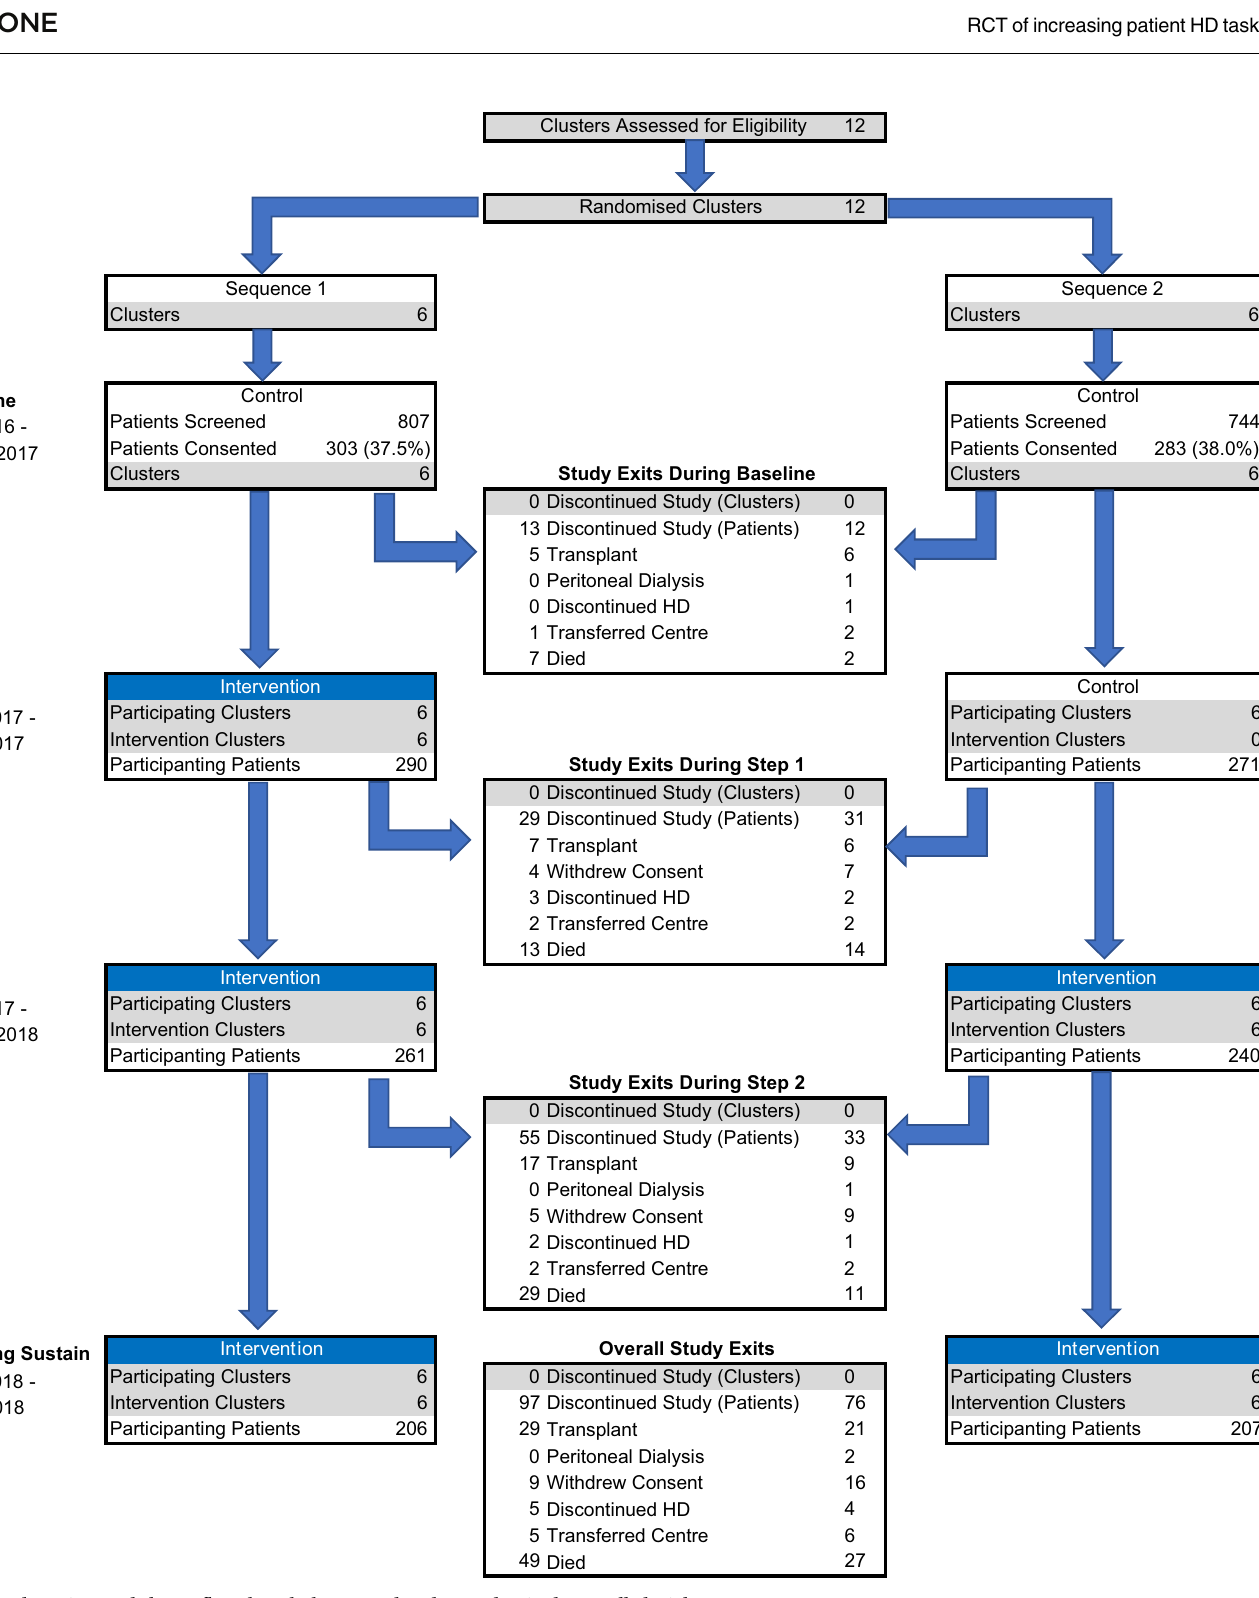
PLOS ONE | https://doi.org/10.1371/journal.pone.0253966 July 20,